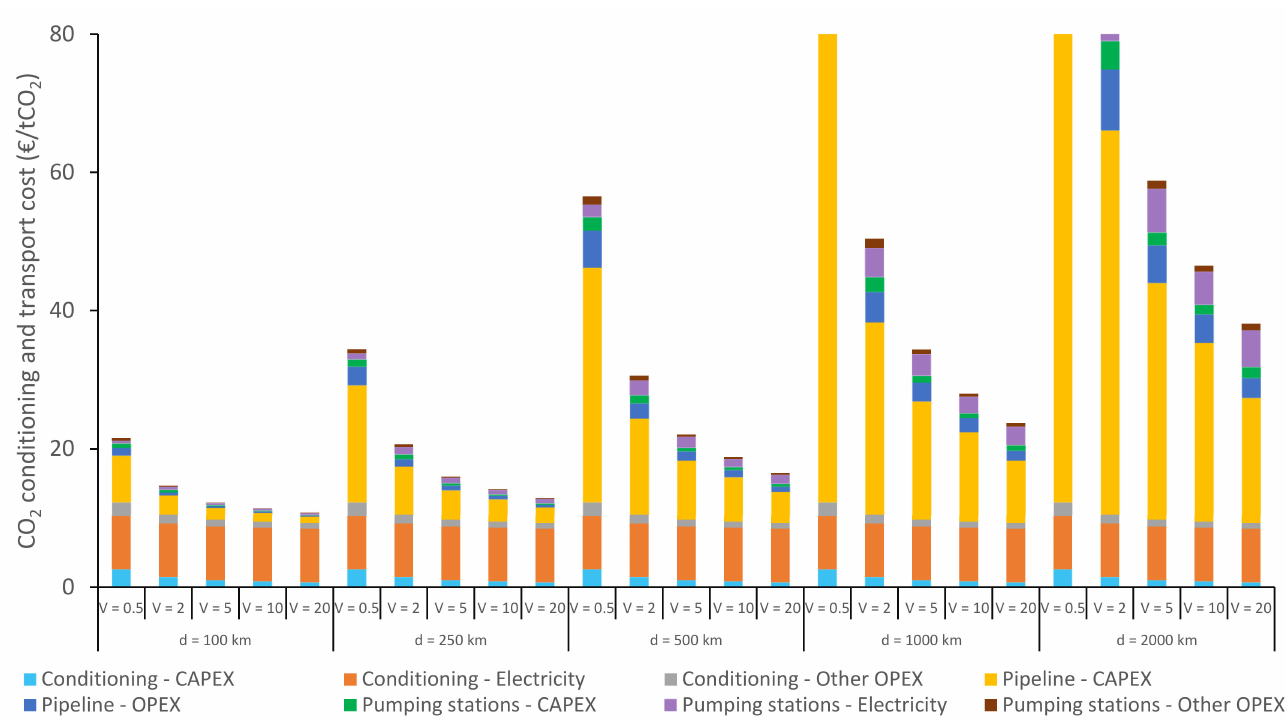
Figure A10. Cost breakdown of CO 2 conditioning and transport costs as a function of transport distance (d in km) and annual volume (V in MtCO 2 /year) when transporting pure CO 2 between two onshore locations using an onshore pipeline (the upper y-axis is here limited to 80 € /tCO 2 , which means that some of the cost breakdown data are not displayed in full).